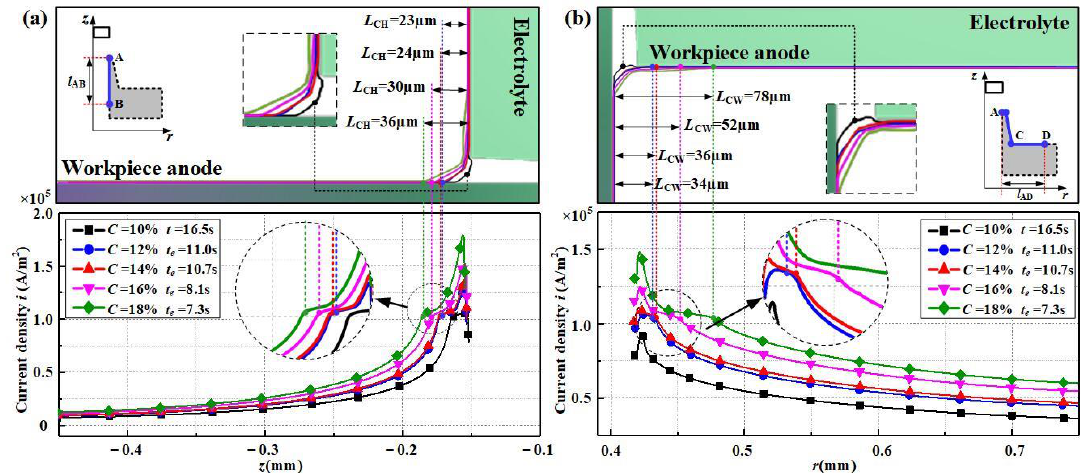
Figure 11. Effect of electrolyte concentration: ( a ) Current density distribution of l AB ; ( b ) Current density distribution of l AD .